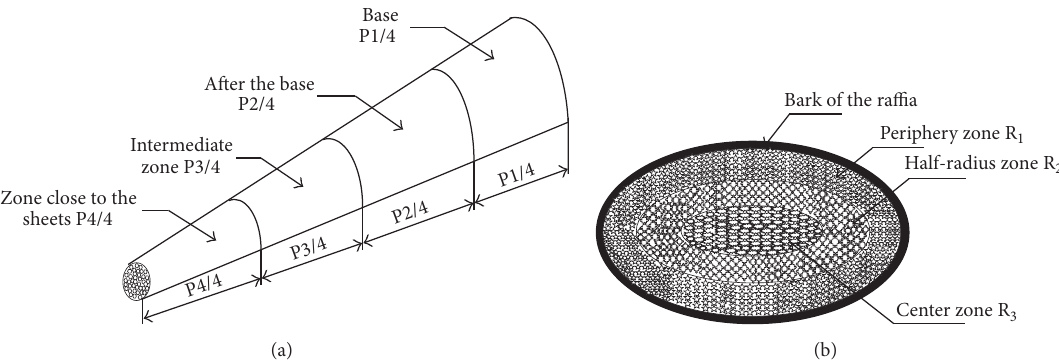
Figure 1: Localization of the sampling zone on the stem of raffia. (a) Longitudinal position and (b) radial position corresponding to each longitudinal position [1, 4,